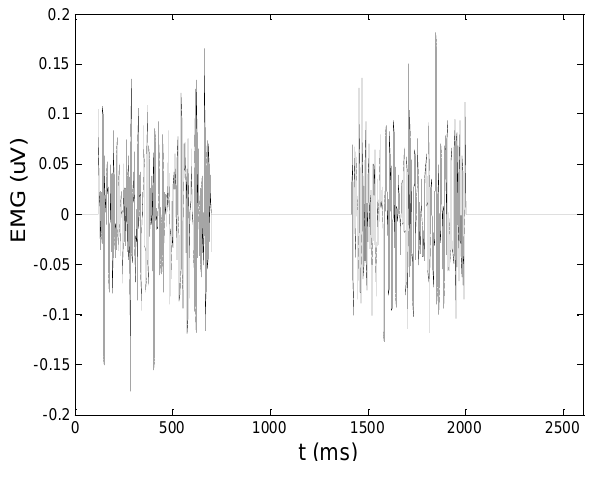
Figure 7. Simulated artificial EMG